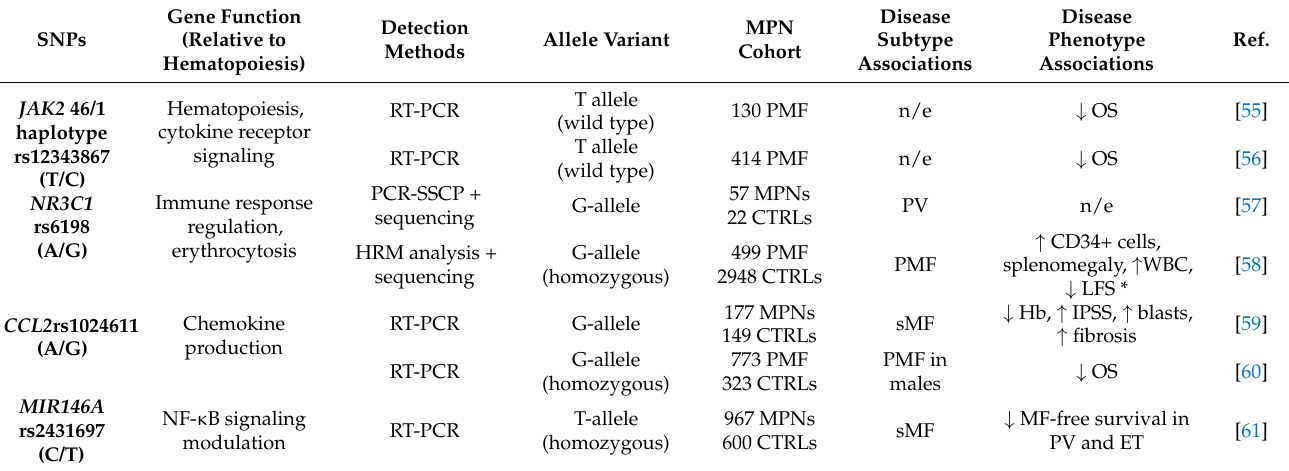
Table 2. Host genetic variants affecting MPN phenotype and/or outcome. Detection Allele Variant Methods